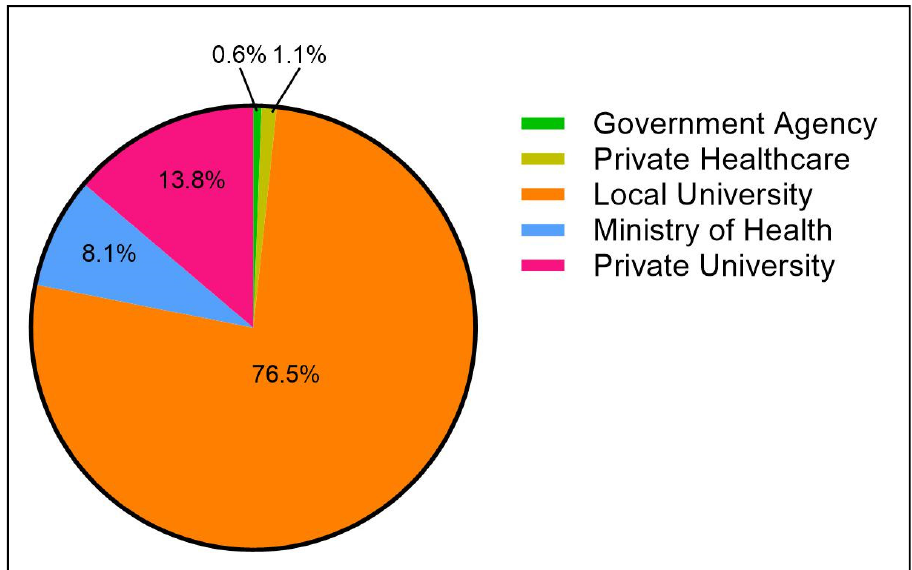
Figure 6. Contributing institutions toward diabetes research productivity.